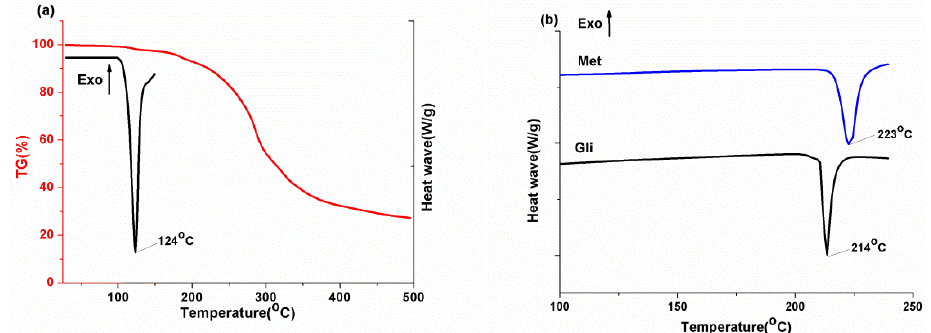
Figure 2. ( a ) Differential scanning calorimetry (DSC) and thermogravimetric analysis (TGA) thermograms of Gli ‐ Met; ( b ) DSC thermograms of Met and Gli.